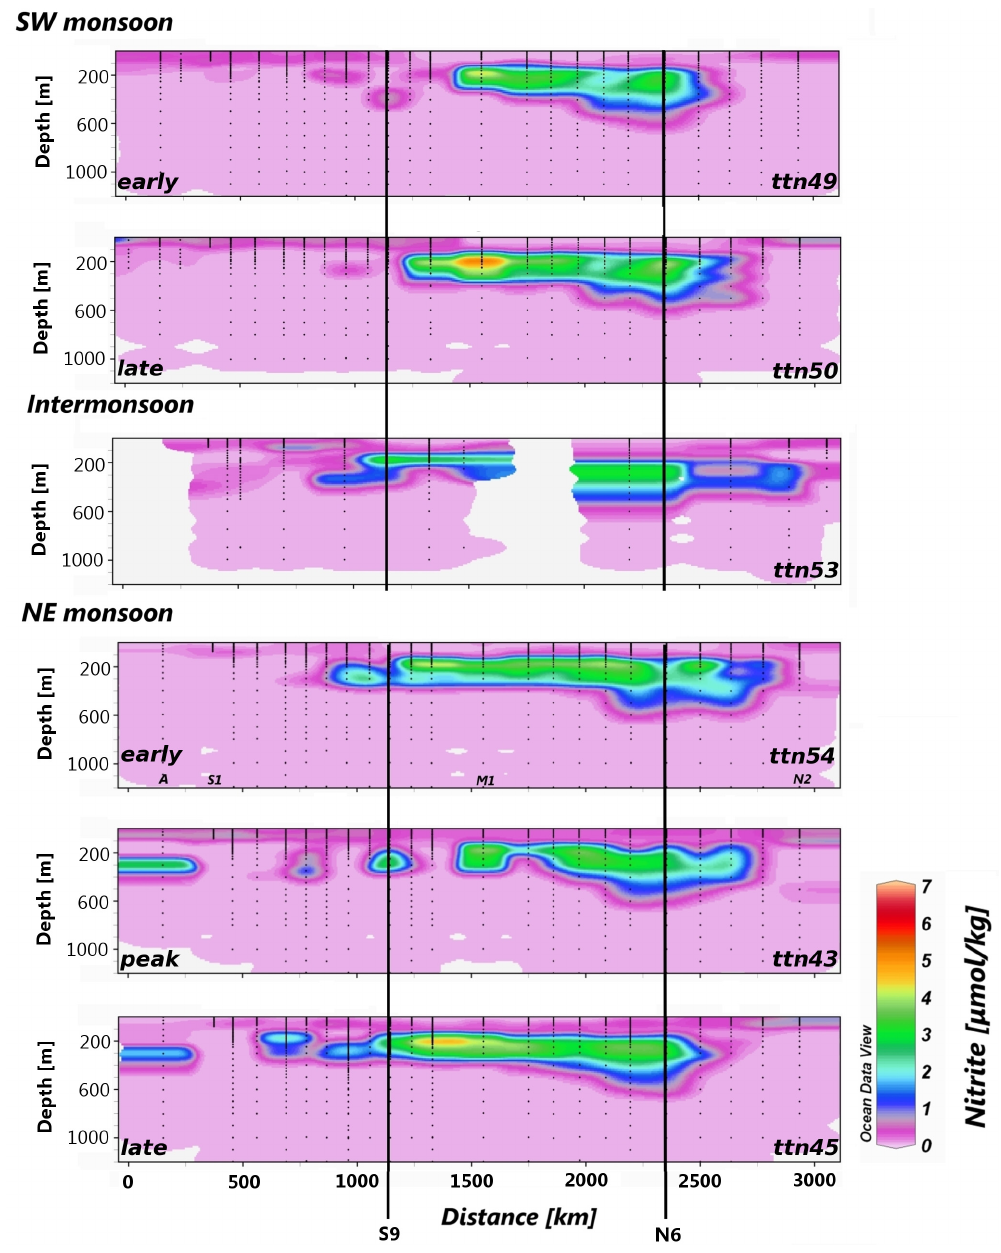
Figure 4. Cross sections showing the seasonal nitrite concentrations along the JGOFS transects from the Oman coast (station A, S1) towards the central and eastern Arabian Sea (stations M1) and the northern part of the eastern Arabian Sea (M1 – N2; compare Fig. 3a, Table 1). The vertical black line shows the maximum expansion of the core of the denitrifying zone in